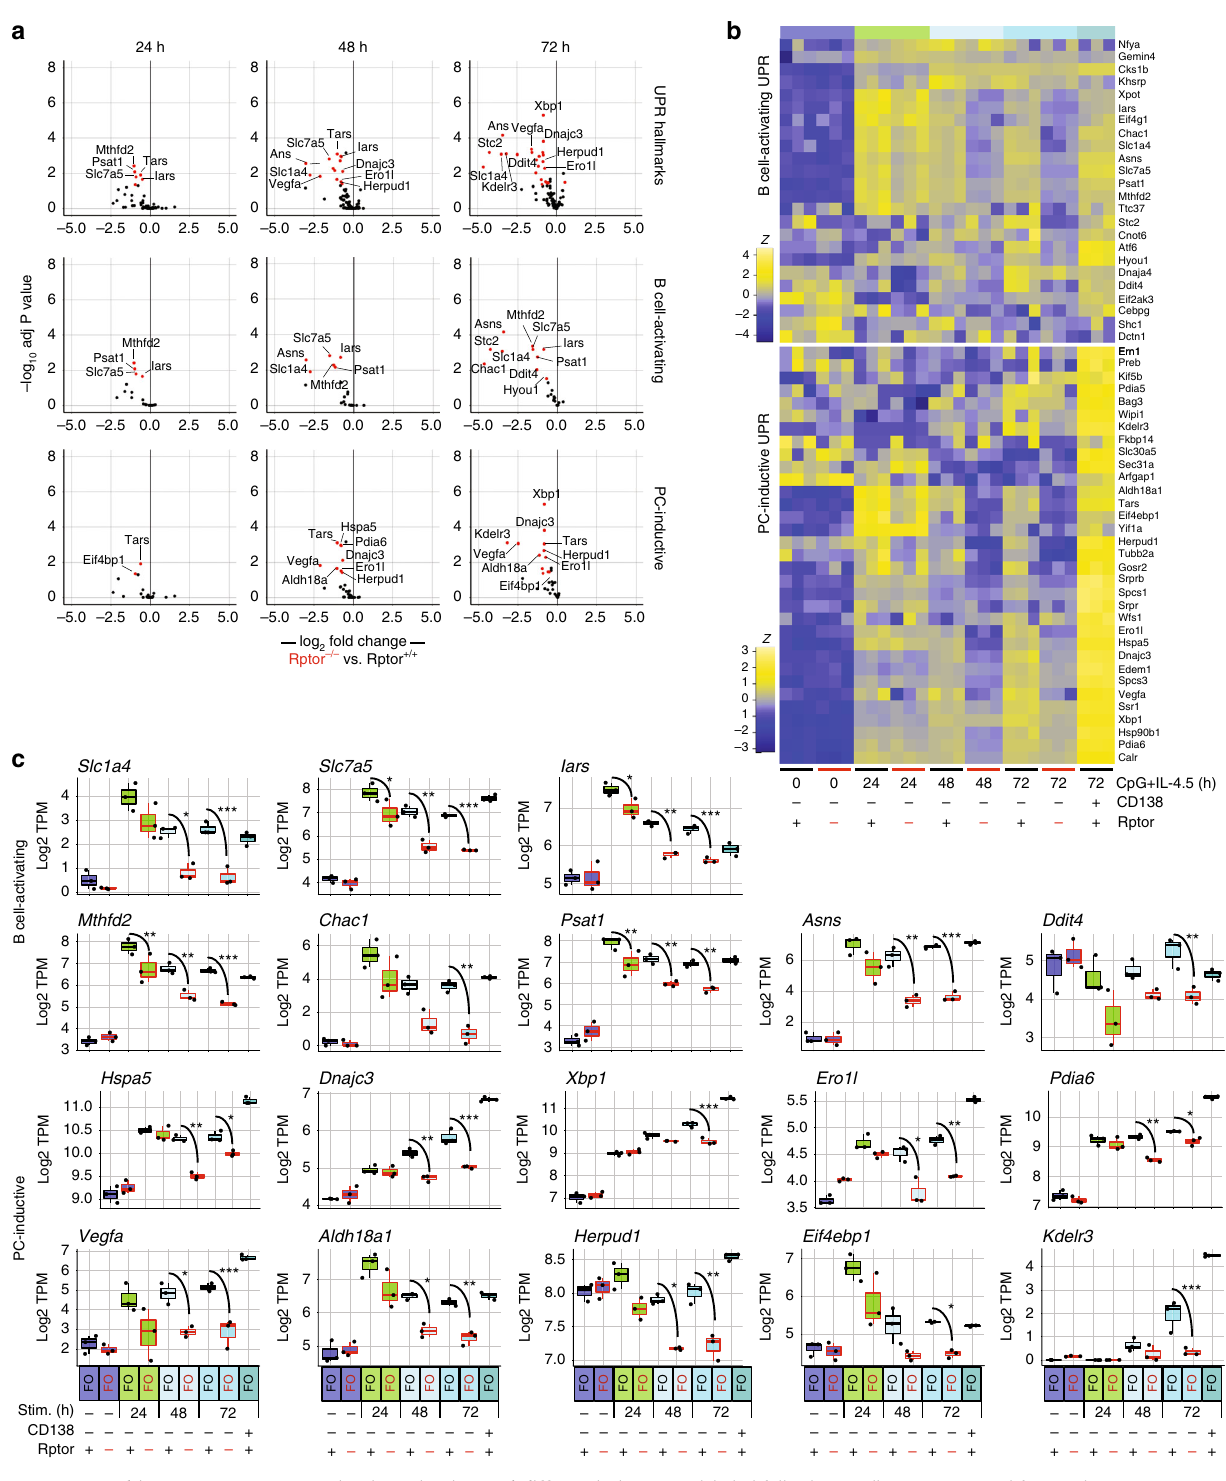
Fig. 7 mTORC1-driven UPR gene expression in activation and differentiation. CTV-labeled follicular B cells were prepared from either CD20-TAM-Cre (Rptor + / + ) ( n = 3) or Rptor1 fl / fl ;CD20-TAM-Cre (Rptor − / − ) ( n = 3) animals after 10 days of tamoxifen diet. Sorting was performed as in Supplementary Fig. 1e. These cells were stimulated in vitro with CpG + IL-4,5 for 24, 48, or 72h and live cells were sorted by CD138 staining. RNA-seq libraries were prepared from cDNA extracted from the resulting populations. a Volcano plots display differential expression of UPR hallmark genes and the gene sets de fi ned in Fig. 3c for indicated treatment time points comparing Rptor − / − populations to Rptor + / + controls (group n = 3 animals). Genes are color coded by the differential expression statistic p <0.05, log 2 fold change>1 (BH-adjusted p -value — eBayes method — Limma). b Expression of B-cell activating and plasma cell-inductive UPR genes as de fi ned in Fig. 3c are shown for each animal and in vitro-treatment time point as the z score across each row. c , Log 2 TPM magnitude of expression of selected genes in each gene set is shown as mean (line), 75%CI (box) and 95%CI (whisker), as well as individual data points (jitter) (* p <.05, ** p <.01, *** p <.001; differential expression statistic: BH-adjusted p -value — eBayes method — Limma). Source data are provided as a Source Data fi